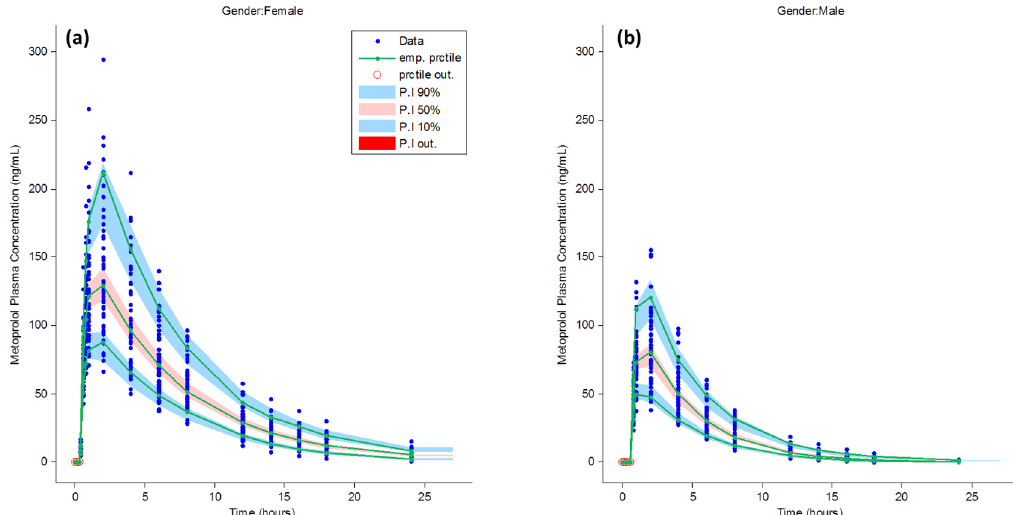
Figure 5. The prediction ‐ corrected visual predictive check (PC ‐ VPC) for a clinical trial simulation of metoprolol concentration–time plasma levels for healthy young women ( a ) and men ( b ). The shaded regions depict the 95% confidence intervals around the 10th, 50th, and 90th percentile range of plasma concentrations, while the solid line illustrates the average population pharmacokinetic metoprolol concentration. Emp. Prctile is the empirical percentile, prctile out is the percentile out, P.I. 90%, 50%, 10% and P.I. out are the 95% confidence intervals for the 10 th , 50 th , and 90 th percentiles while the P.I. out is the data predicted percentile out of the PC ‐ VPC prediction interval(s). Table 2. Gender ‐ stratified population pharmacokinetic model estimates from the Clinical Trial Simulation (CTS).